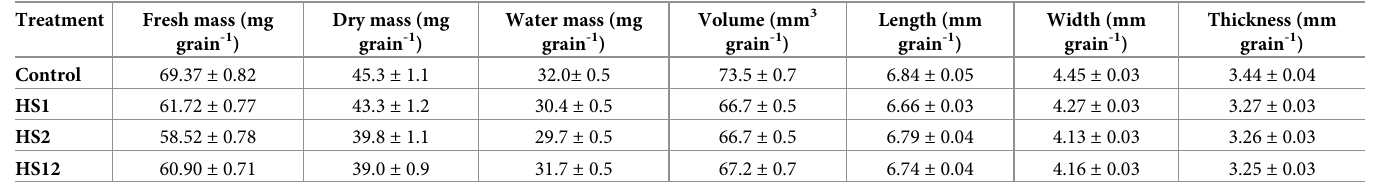
Table 2. Estimated maximum values of the various traits of basal grains from the central spikelets of wheat plants exposed to heat shocks. Treatment